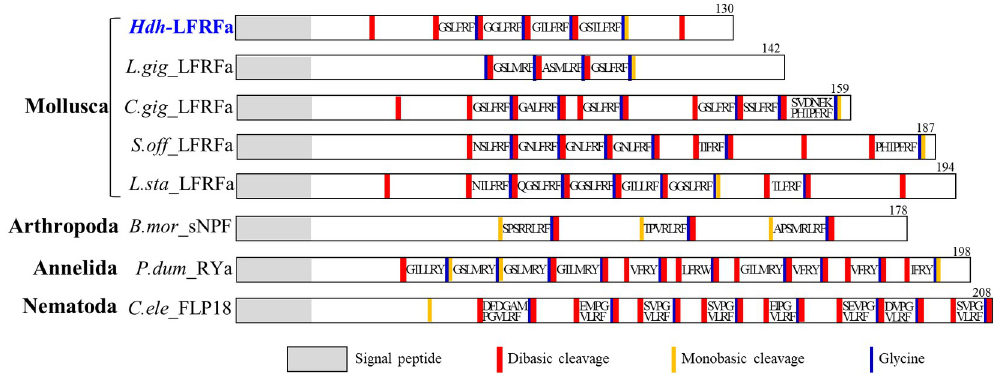
Fig 2. Amino acid sequence analysis of Haliotis discus hannai LFRFamide (Hdh-LFRFa) precursor. Comparison of the linear schematic organization of LFRFa/sNPF-related precursors in invertebrates. Signal peptides, proteolytic processing sites, and C-terminal glycines for amidation are indicated by distinct